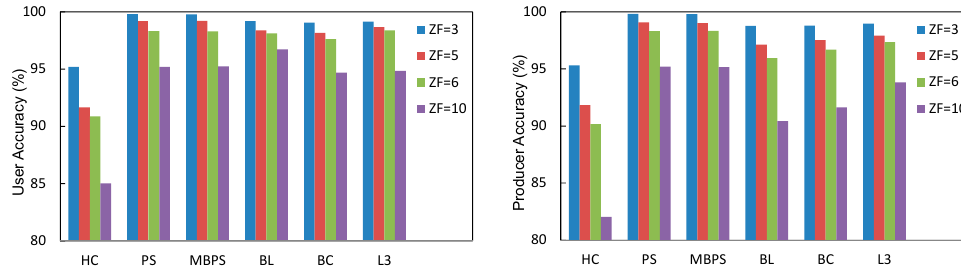
ISPRS Int. J. Geo-Inf. 2017 , 6 , 383